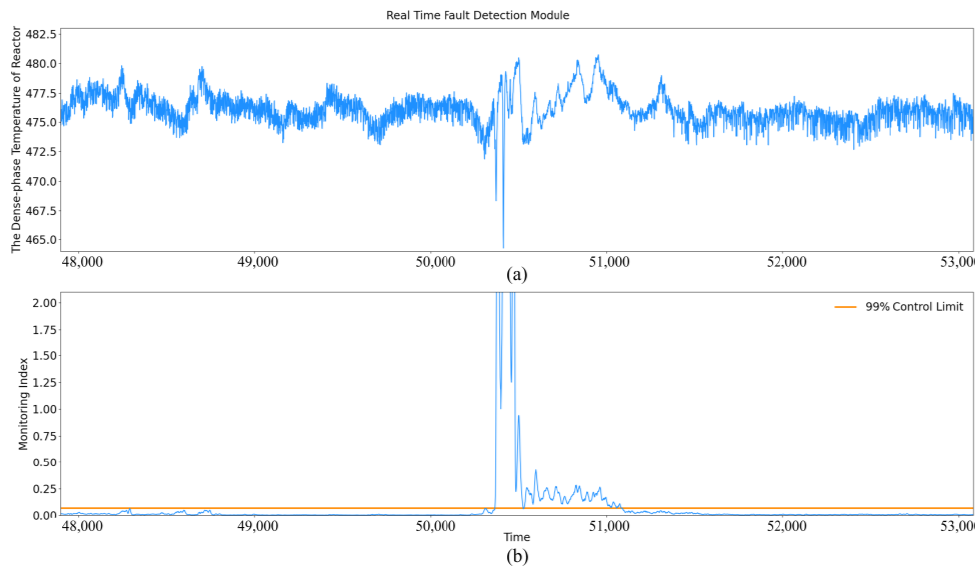
Figure 13. Process monitoring result of the proposed method on case two: (a) Original data of the key variable; (b) Fault detection results.